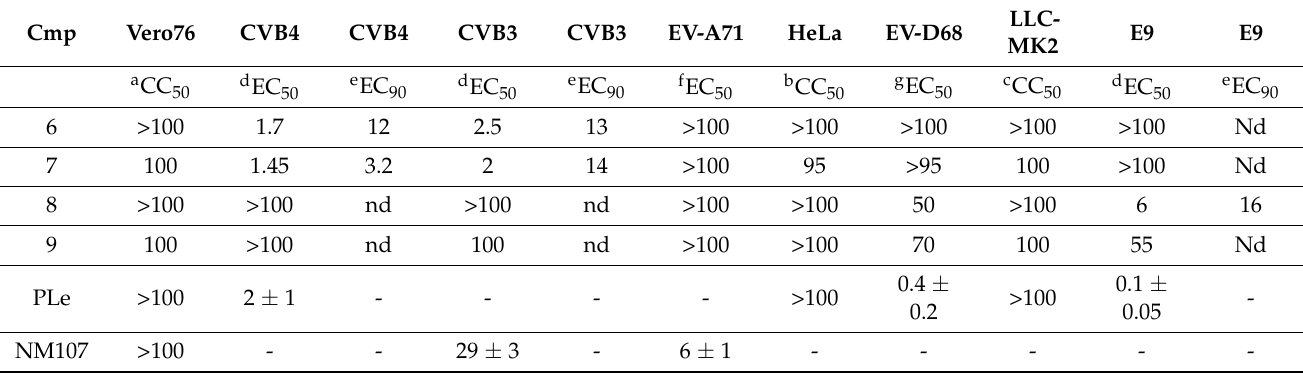
Table 1. Cytotoxicity and antiviral activity of quinoxaline derivatives and reference compounds against representatives of Enterovirus (CVB4, CVB3, EV-A71, EV-D68, and